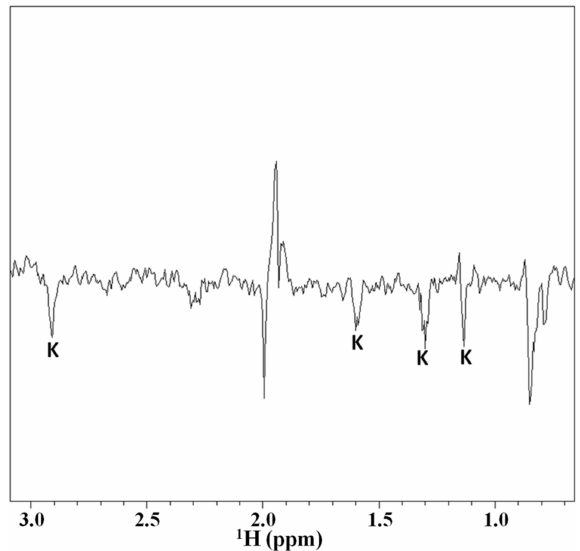
Figure 5. WaterLOGSY spectra obtained with T α 1 0.8 mM and HA 0.4% ( w / w ) H 2 O/D 2 O (90%/10%), the symbol K indicated the lysine proton resonances in the residue side chain.